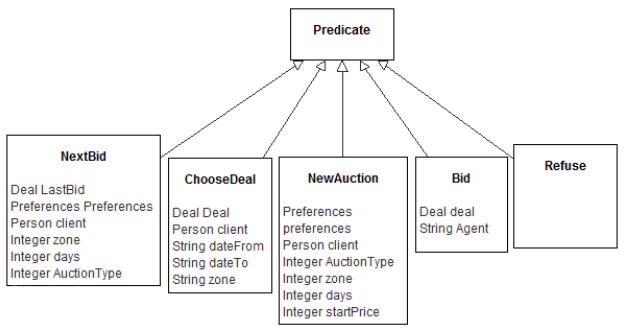
Fig. 5. Predicates defined during the interaction